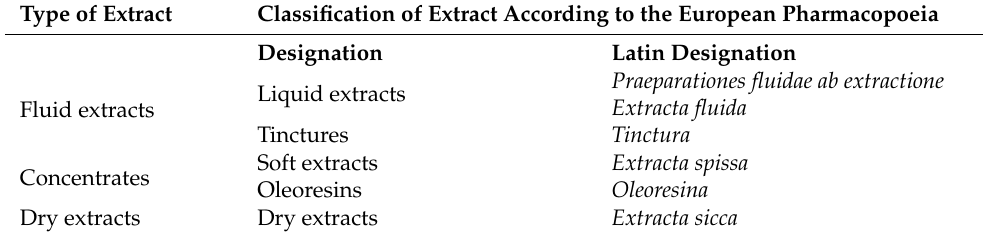
Table 1. Extract types of the European Pharmacopoeia according to the pharmaceutical–technological classification.